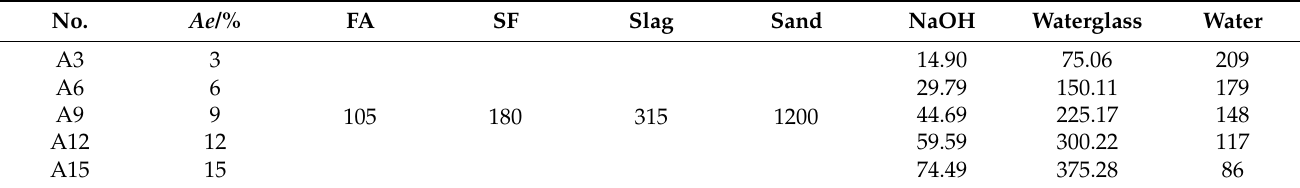
Table 3. Mixture proportions of group A (kg/m 3